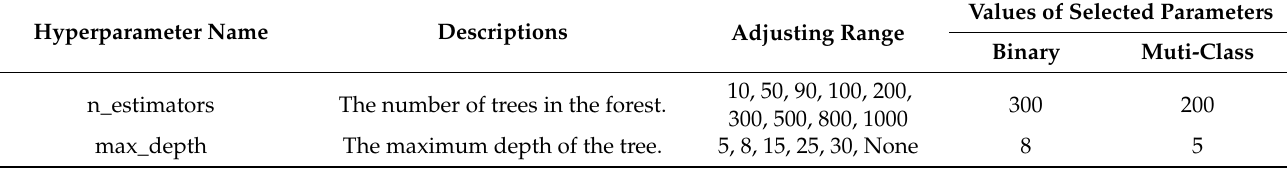
Table 3. Descriptions for the undetermined hyperparameters for the binary RF model and muti-class RF model used for rainfall forecast. For the max_features, ‘sqrt’ indicates that the value is the square root of the number of features, ‘log’ indicates that the value is the logarithm of the number of features, and ‘None’ indicates no